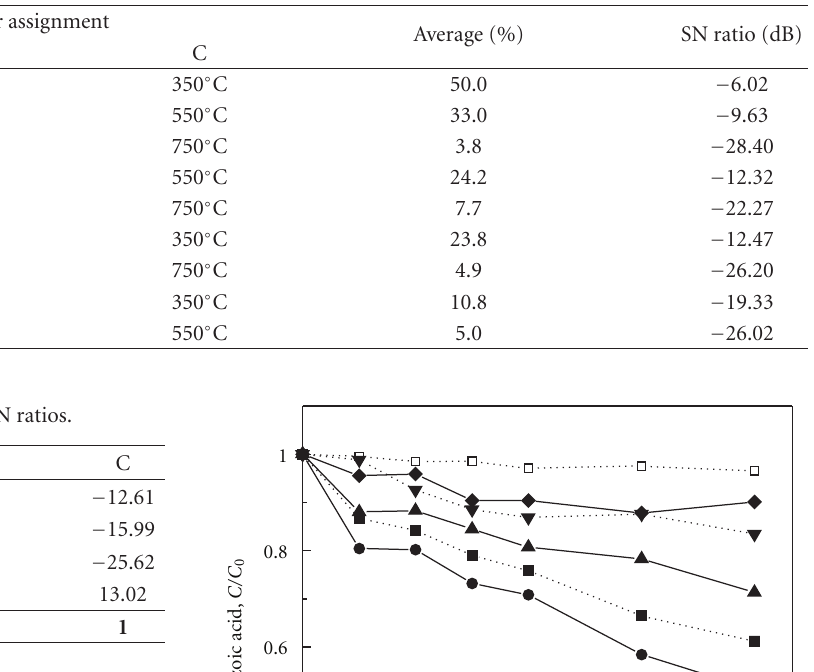
Table 4: The L9 experimental layout and experimental results.